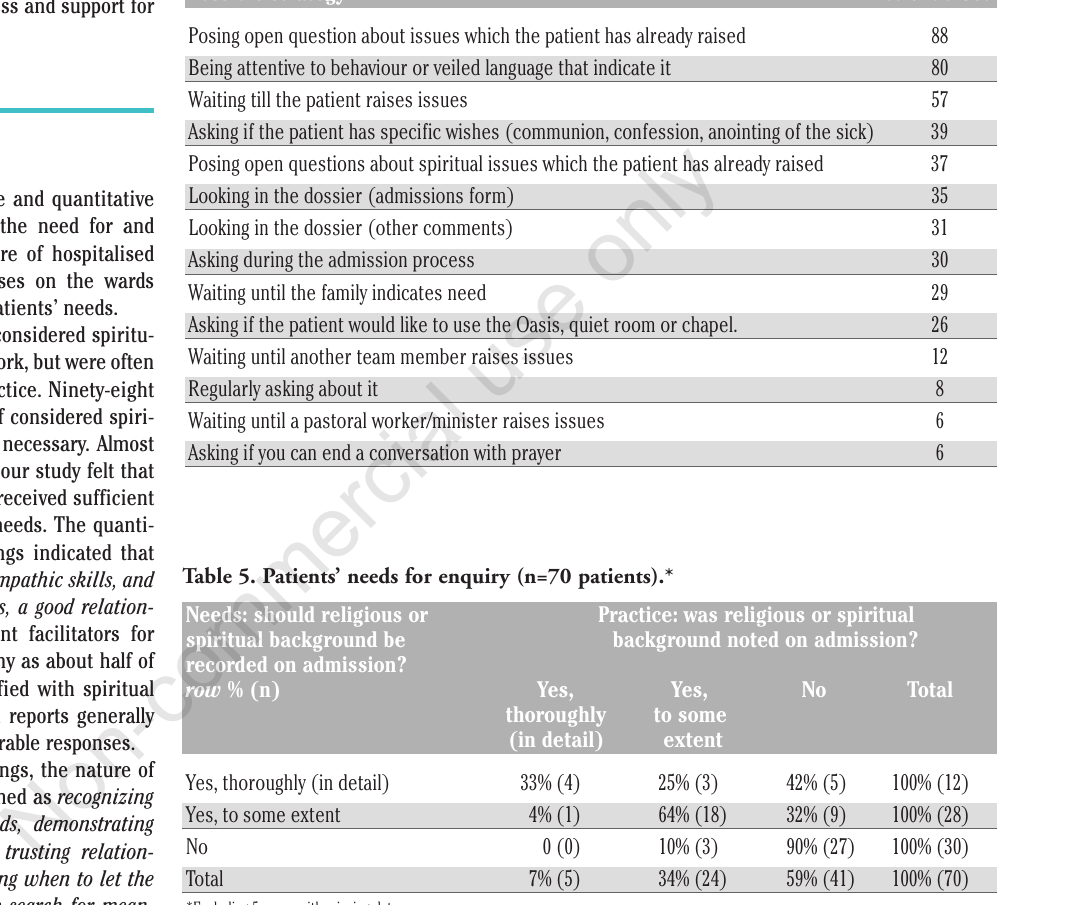
Table 4. Nurses’ strategies to assess patient’s spiritual questions and/or needs (n=51 nurses). Possible strategy